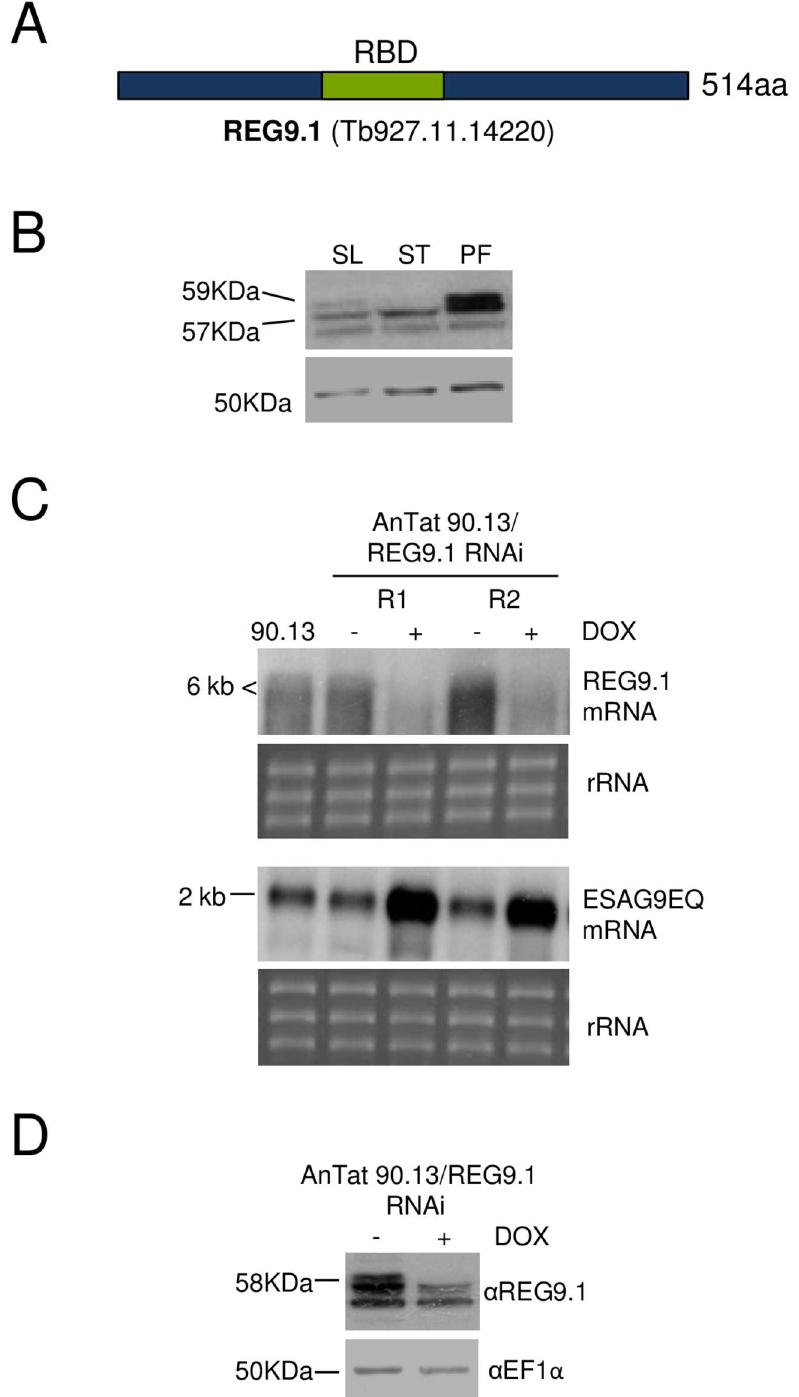
Fig 3. REG9.1 developmental expression profile and REG9.1 RNAi in pleomorphic parasites. A. Schematicrepresentation of REG9.1 showingthe positionof its single predicted RNA bindingdomain(RBD). B. Protein expressionof REG9.1. The antibody detects three bands, the lower bandbeing detected inconsistently betweenblots. The abundance of the two upper bands differ in different life cycle stages, with the uppermost bandbeing less abundant in stumpy forms. Procyclic forms express more REG9.1 than bloodstream forms. C. Northern blot for REG9 . 1 and ESAG9 - EQ in the parental line ( T . brucei AnTat90:13)